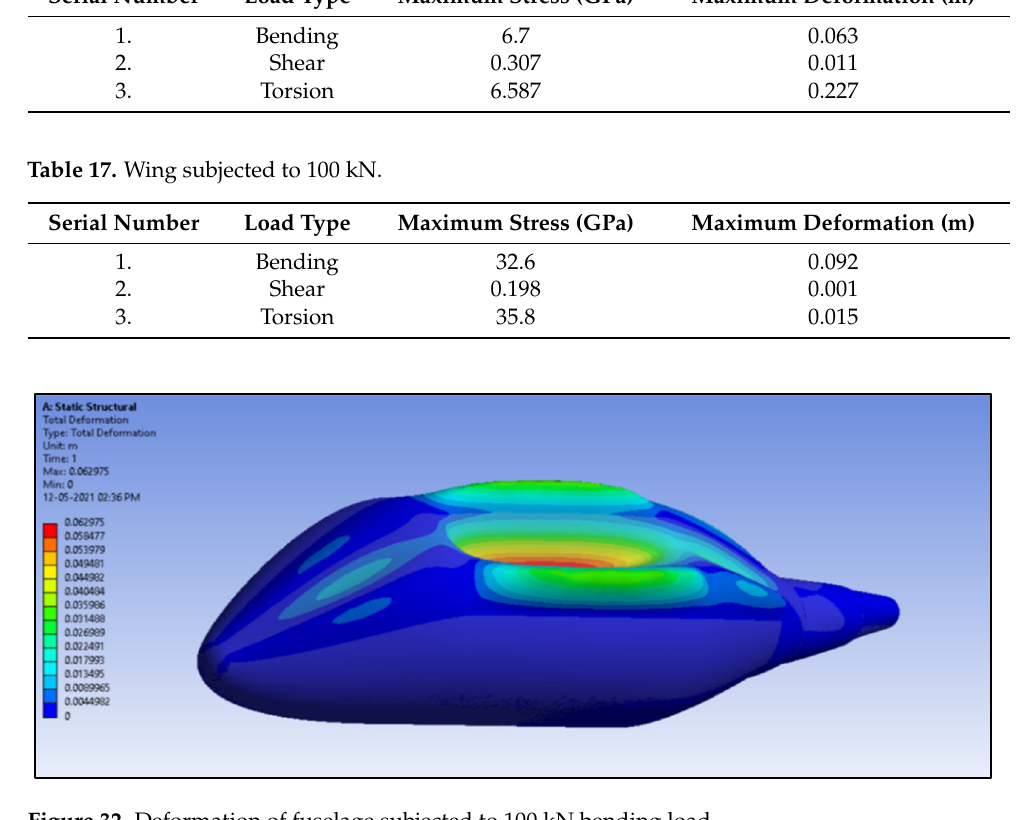
Table 16. Fuselage subjected to 100 kN.